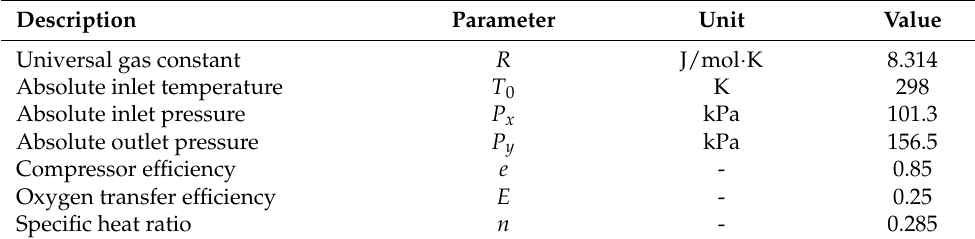
Table 3. Power requirement assumptions